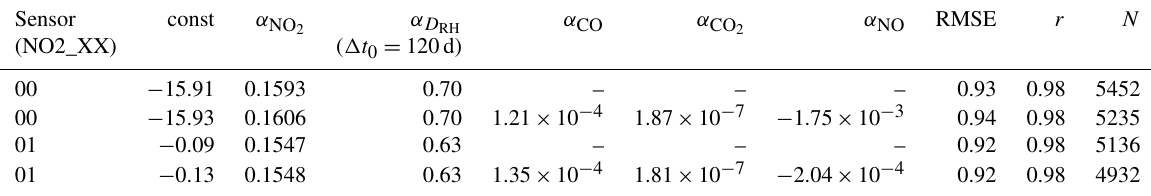
Table 2. Numeric values of the parameters α i (Eq. 1) of two models derived from data from the three test series depicted in Fig. 2. The parameters α CO , α CO and α NO were omitted in the first model and estimated in the second model. r denotes the Pearson correlation 2 coefficient and N the number of 1min measurements used for the parameter estimation. Units for coefficients α i are mVppb − 1 , for RMSE is